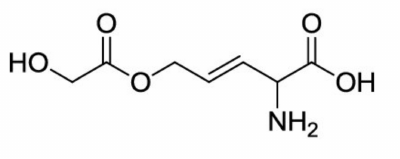
Figure 3. Chemical structure of